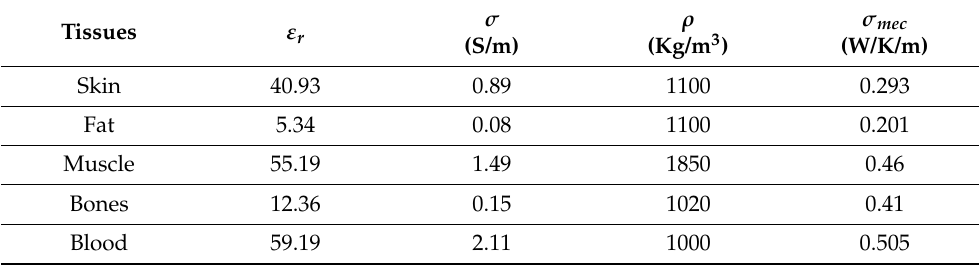
Table 1. Dispersion characteristics of human tissue layers at 2.4 GHz. Tissues